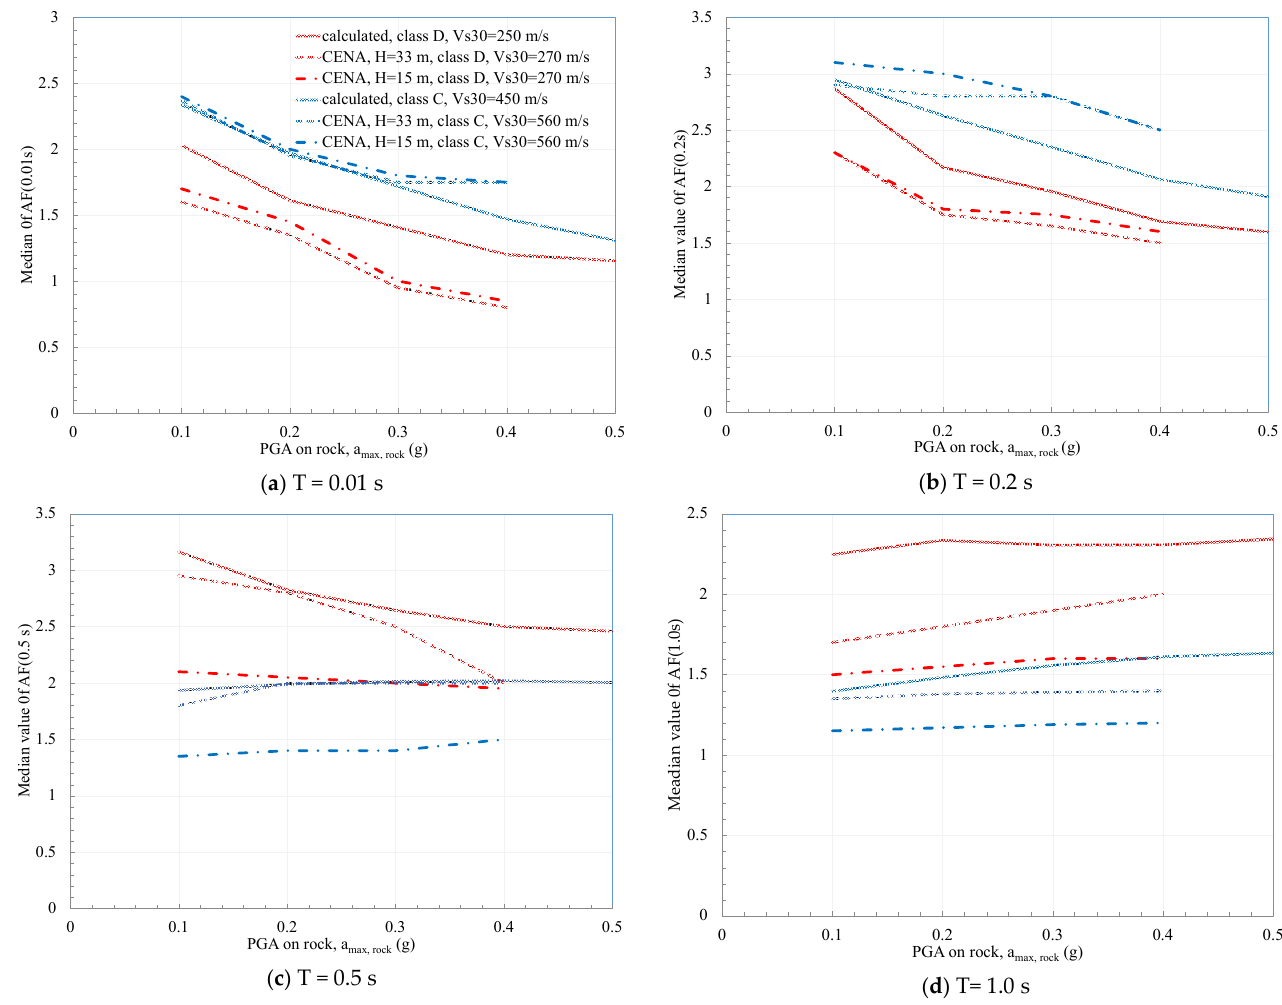
Figure 16. Median amplification factors as a function of PGA rock for site classes C and D at periods of ( a ) 0.01 s, ( b ) 0.2 s, ( c ) 0.5 s and ( d ) 1.0 s (RDQ = 5, Vs = 2900 m/s) for Montreal sites and CENA [37] sites.